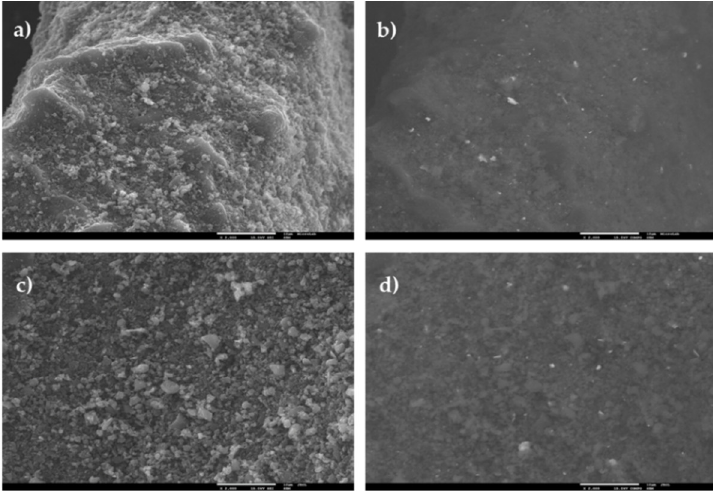
Figure 2. SEM images of AC-Pd1 ( a , b ), AC-Pd2 ( c , d ), 10 µm scale ( a , c ) and 2000× magnification ( b , d ).